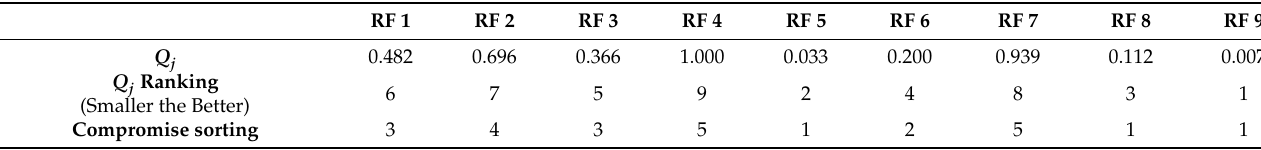
Figure 7. Second HoQ between RCs and RFs. Table 15. Compromise sorting of